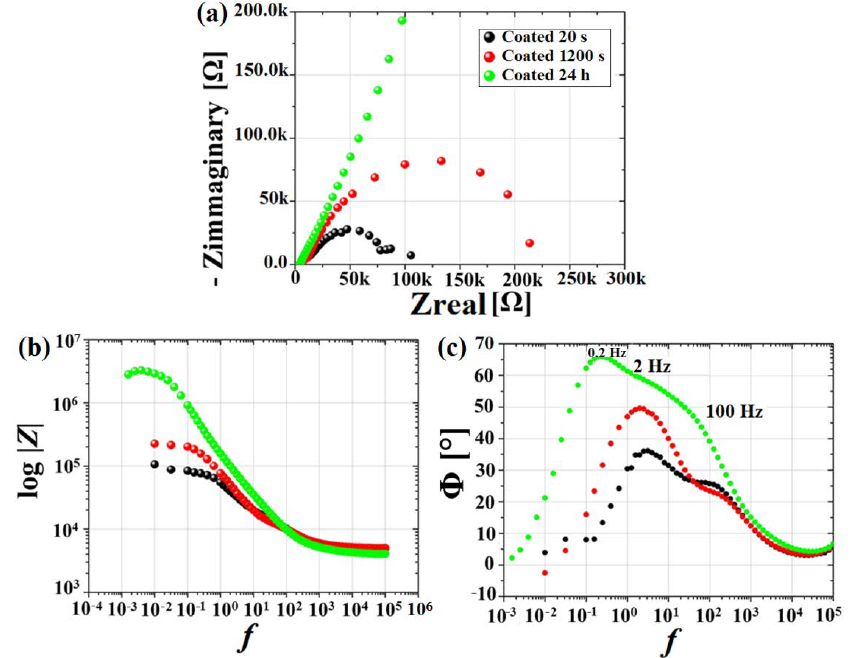
Figure 12. EIS spectra obtained for coated samples at the start (20 s) and after 1200 s and 24 h of exposure to the electrolyte. Nyquist plot ( a ); Bode modulus ( b ); Bode phase ( c ).